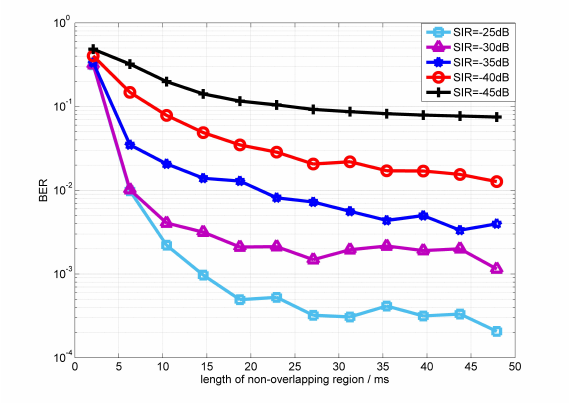
Figure 11. BER convergence performance of the OPRLS with sparse constraints in different